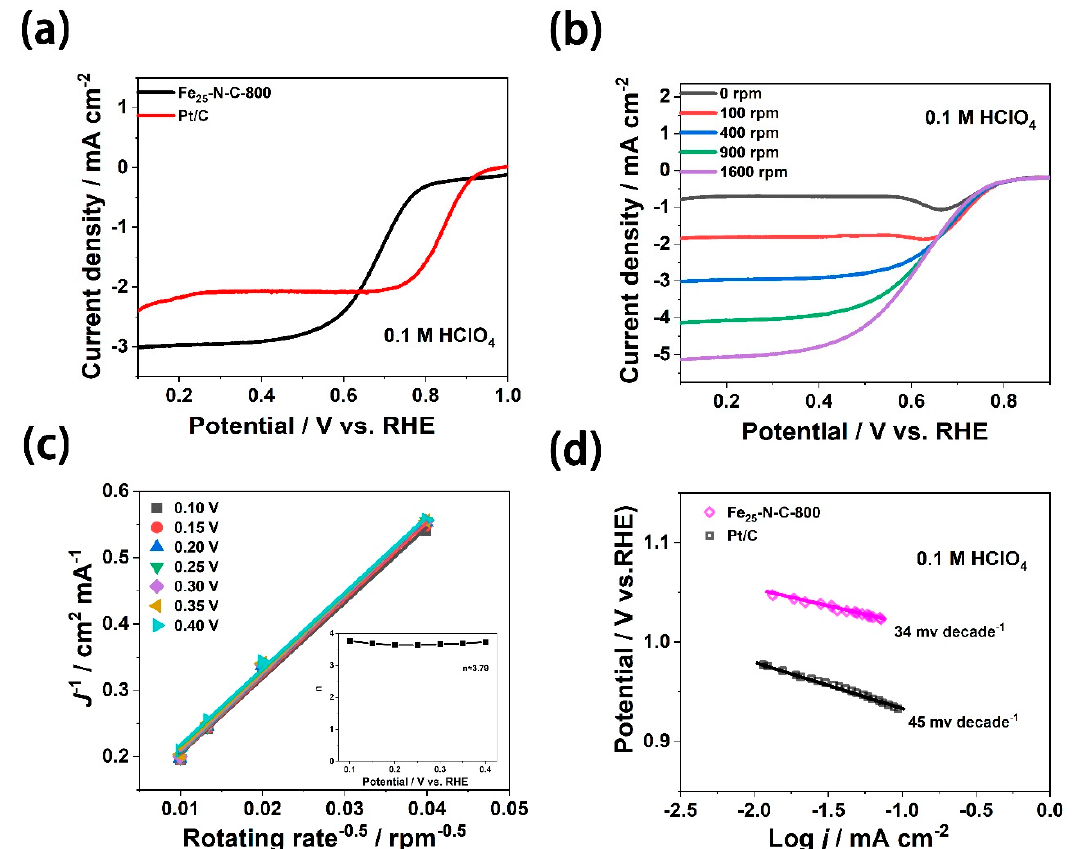
Figure 6. Characterizations of ORR activity in acidic medium. ( a ) RDE dates of Fe 25 -N-C-800 and Pt / C, rotation rate = 400 rpm. ( b ) Polarization curves of Fe 25 -N-C-800 at various rotation rates (increasing from top to bottom). ( c ) Koutecky–Levich plots of Fe 25 -N-C-800 and number of electrons transferred (inset) at various potentials (0.1–0.4 V vs. RHE). ( d ) Tafel slope plots of Fe 25 -N-C-800 and Pt / C derived from the LSV results.